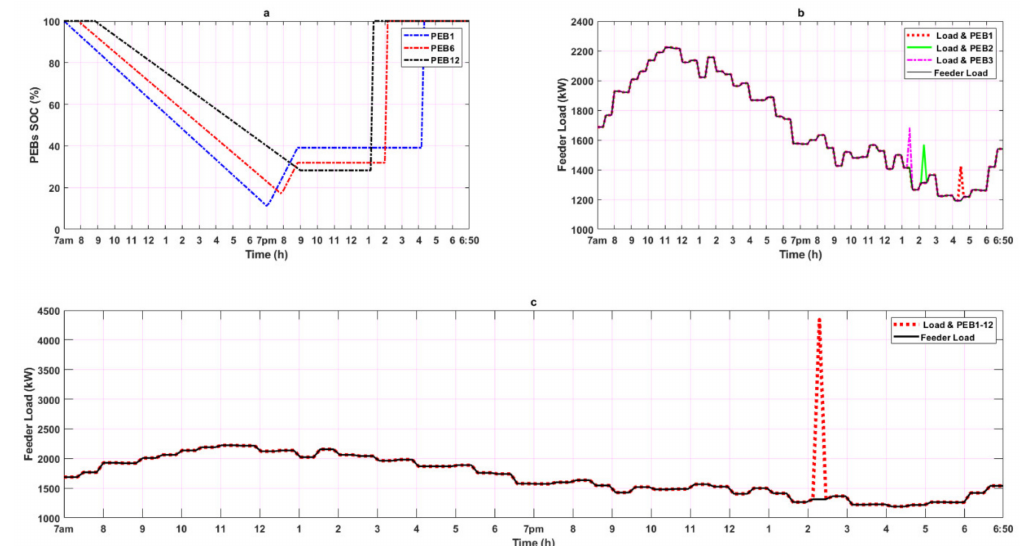
Figure 5. Coordinated and limited charging: (a) state of charge ( SOC ) of three PEBs; (b) impact of charging three PEBs; and (c) impact of charging 12 PEBs on the low voltage (LV) feeder.